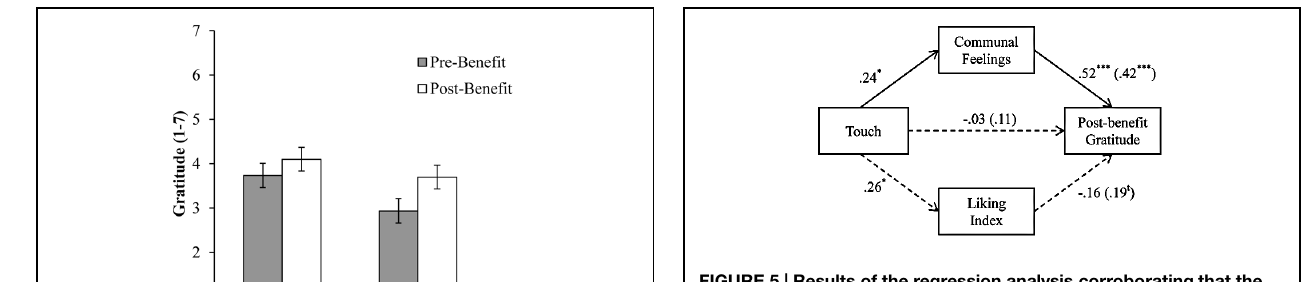
FIGURE 5 | Results of the regression analysis corroborating that the effect of touch on post-benefit gratitude is mediated by communal feelings (vs. liking) in Study 2. The numbers are standardized regression coefficients. The numbers outside parentheses represent β -weights when all variables are used concurrently as predictors, whereas the numbers in parentheses are zero-order correlations. t p < 0.10; ∗ p < 0.05; ∗∗∗ p < 0.001.